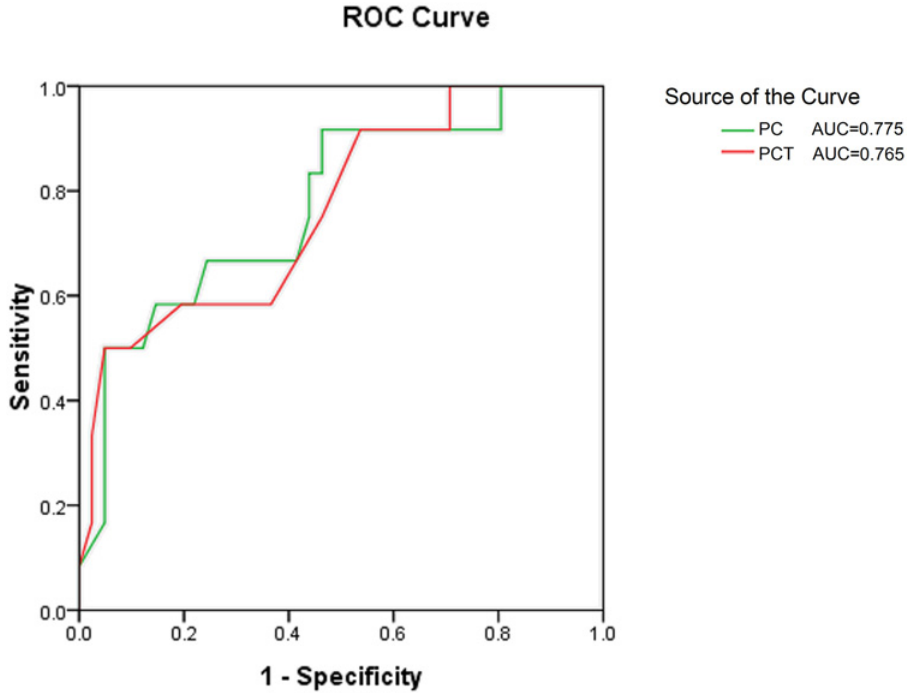
Fig 2. Receiver operating characteristic curves for predicting mortality in IFD infants by platelet count (PC) and plateletcrit (PCT). For each indicator, sensitivity (true positive rate) is plotted against 1-specificity (false positive rate). Accuracy is measured by the area under the ROC curve. The AUCs for PC and PCT were 0.775 (95% CI: 0.629 – 0.920, p = .002) and 0.765 (95% CI: 0.610 – 0.921, p = .006),